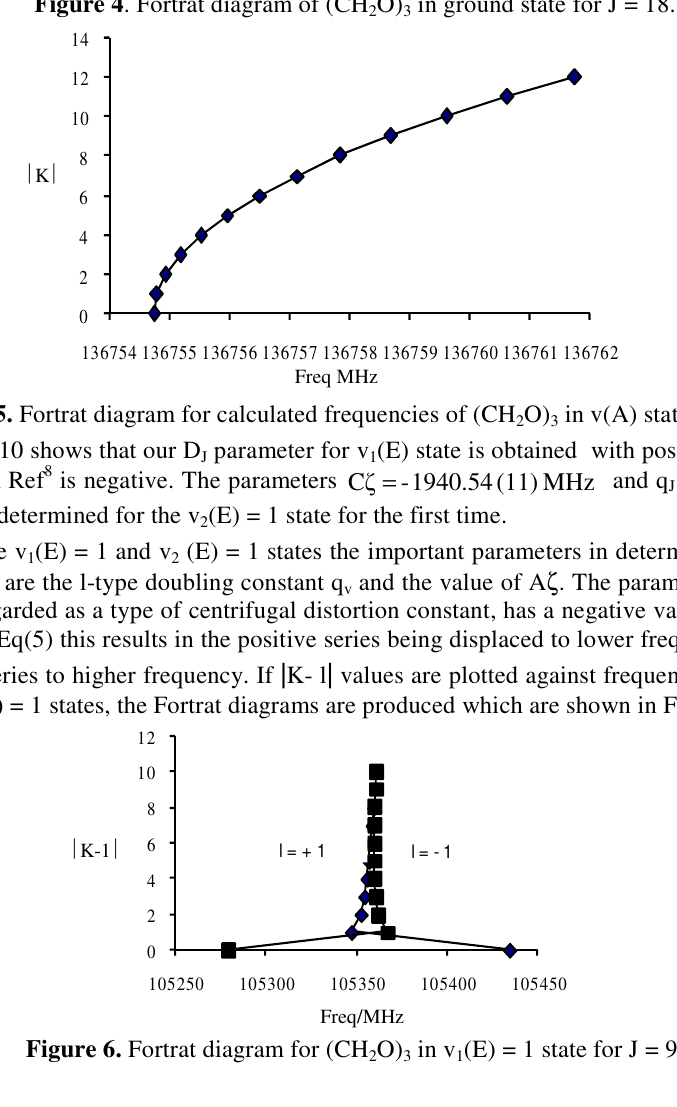
Figure 4 . Fortrat diagram of (CH